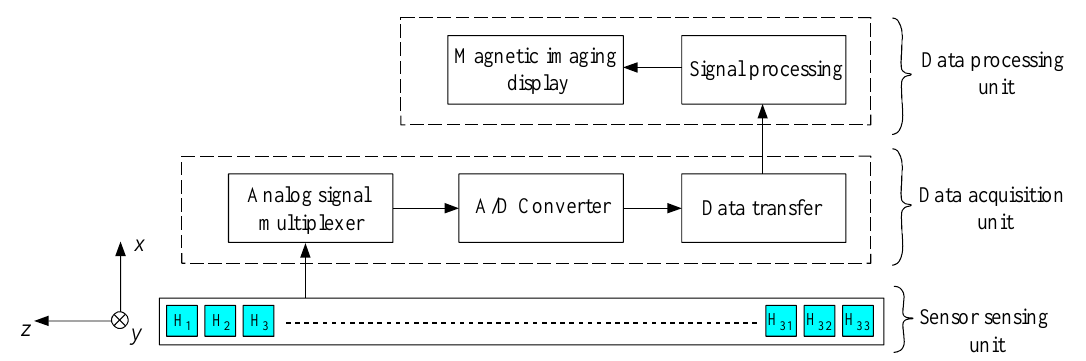
Figure 3. The basic operation of the Mobile Hall Sensor Array